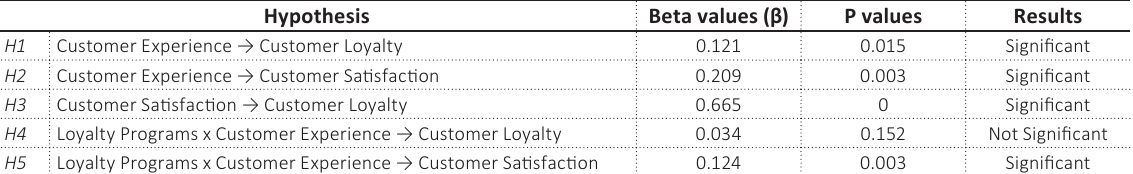
Table 4. Hypotheses